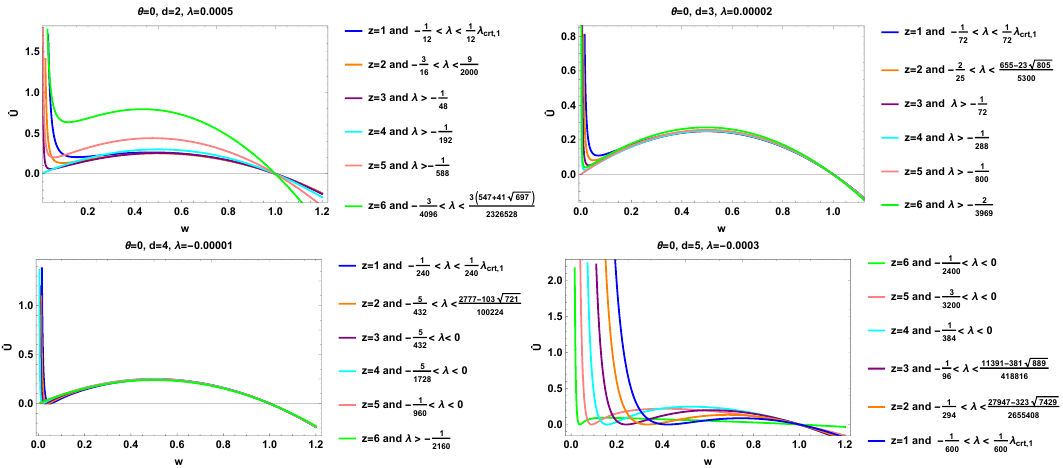
ˆ U ( w ) as a function of w for θ = 0 and different values of d and z . inside the horizon. The appropriate ranges of λ are fB